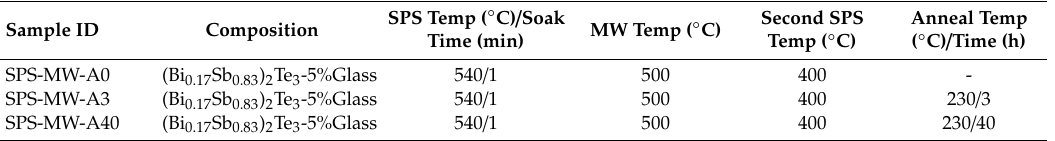
Table 2. Sintering parameters of microwave (MW) processed samples.